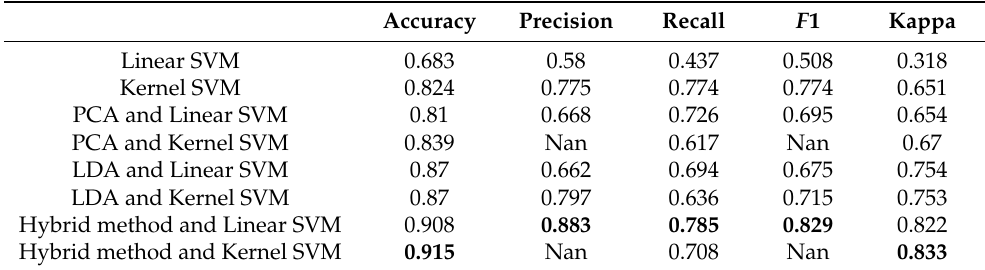
Table 5. Comparison of Different Techniques for the second experiment.